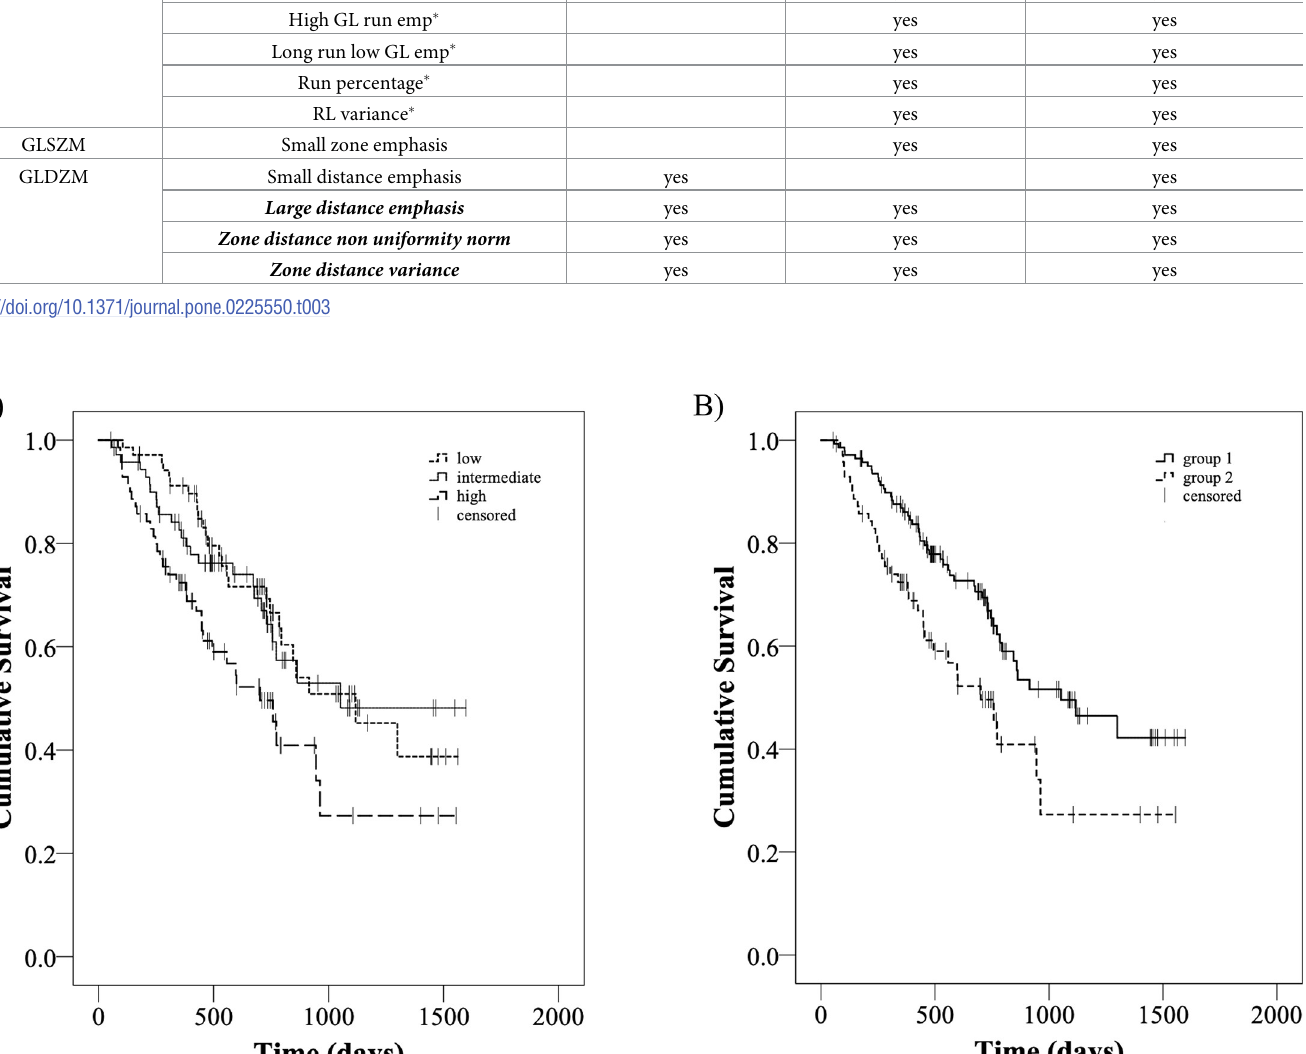
PLOS ONE | https://doi.org/10.1371/journal.pone.0225550 November22,